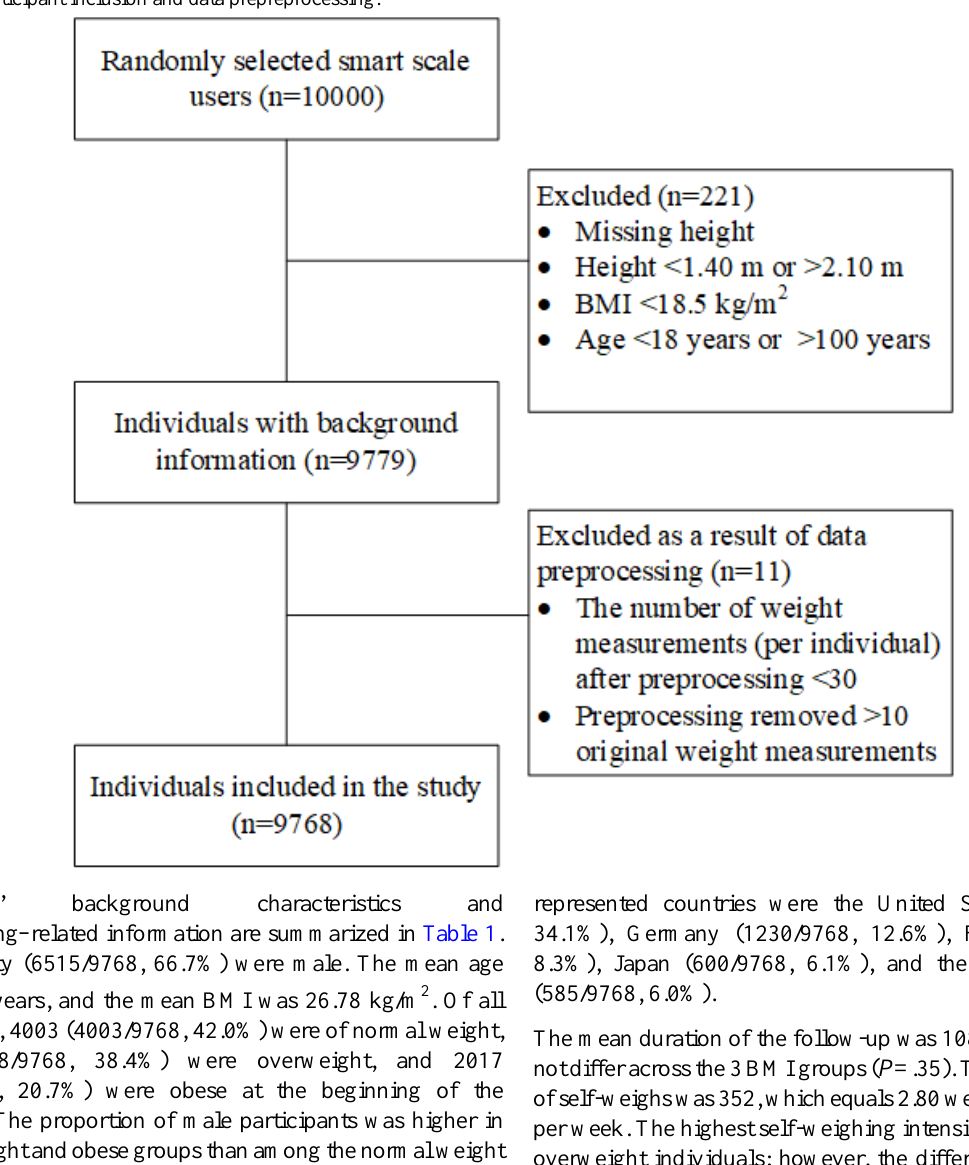
Figure 1. Participant inclusion and data